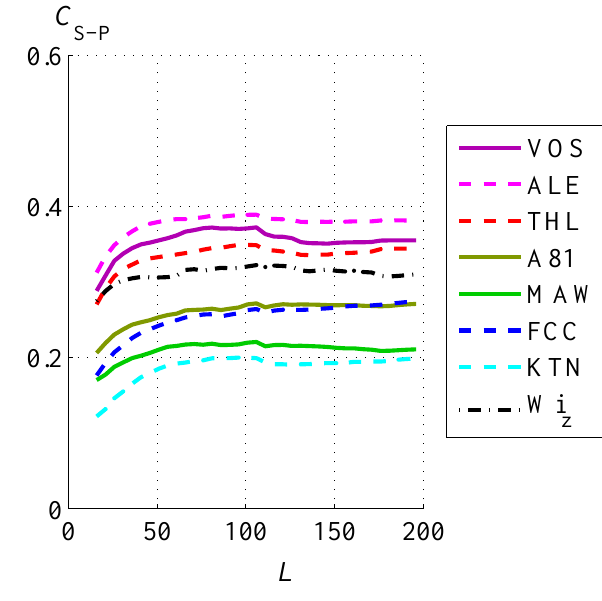
Fig. 2. Averaged over two years (1997–1998) correlation coeffi- cient C between S (1–1.5mHz band) and V for 7 high latitude sta- tions in dependence on sample length L (in points). Solid (dashed) lines correspond to the Southern (Northern) Hemisphere, respec- tively. Warm colors denote polar cap stations, and cold colors de- note auroral stations. Among the Northern auroral stations only those with the maximal and minimal correlations are shown. Black dashed-dotted line shows the correlation between V and the power of IMF B z fluctuations S Bz .